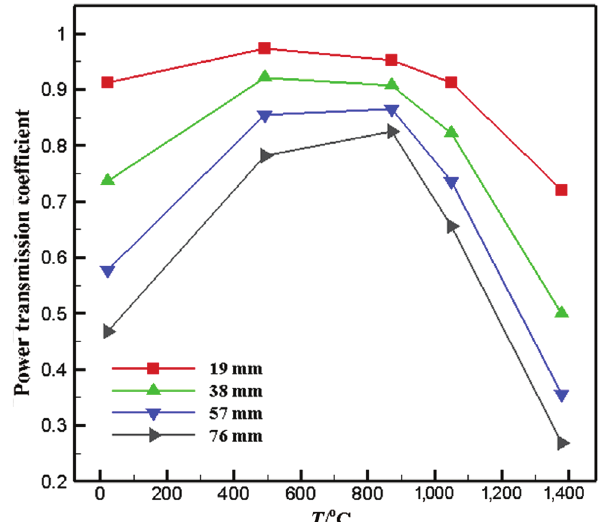
Figure 5: Temperature dependence of PTC of the Al 2 O 3 slab as the thickness varies from 19 mm to 76 mm at 2,450